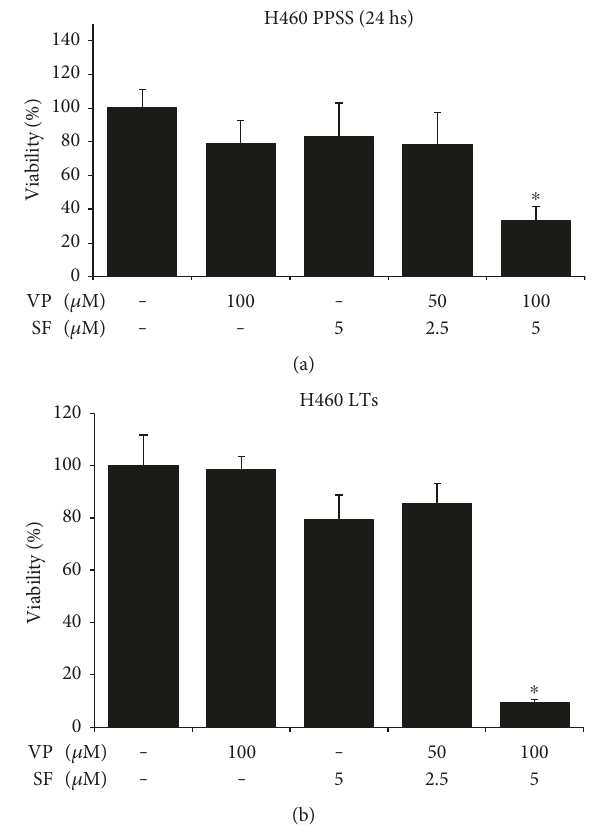
Figure 1: VP in combination with SF signi fi cantly decreases the viability of cells growing under PPSS or as FTs. (a) Cells growing under PPSS for 8 – 10 days were incubated with the indicated concentrations of VP and SF alone or in combination for 24h. Cell viability was measured by the MTT assay. (b) Cells growing as FTs for 14 – 16 days were incubated with the indicated concentrations of VP and SF alone or in combination for 24h. Cell viability was measured by the CCK assay. Results ( X ± SD) are representative of two independent experiments performed in sextuplicate. ∗ indicates P < 0 01